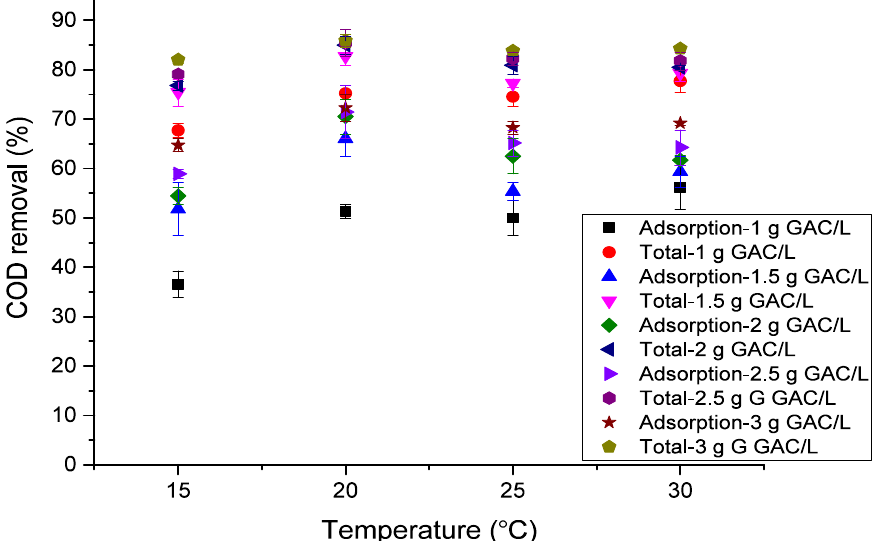
Figure 3. Effect of temperature on COD removal at different granular activated carbon dosages.